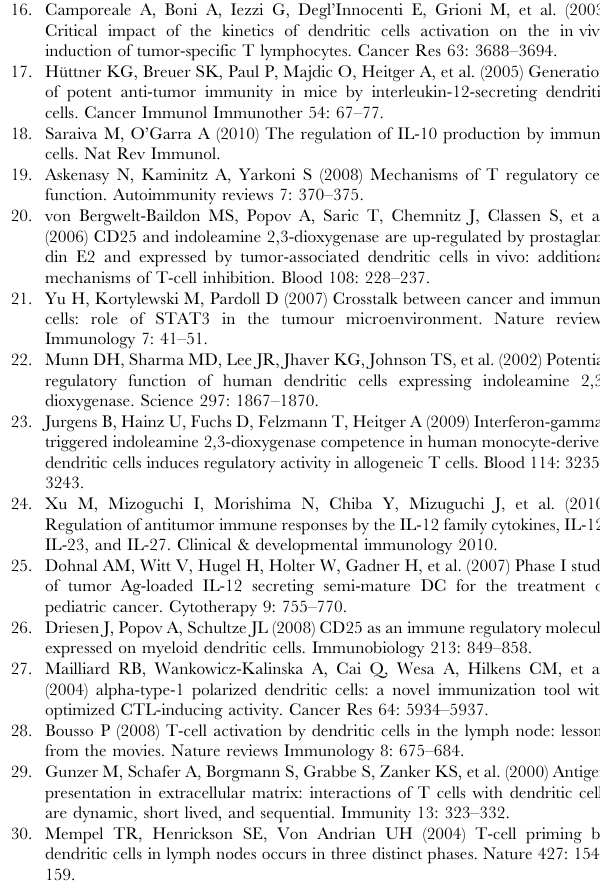
Figure S1 STAT3 expression in DC. (A) Comparison of STAT3 phosphorylation levels in human DCs after exposure to LPS (black line), LPS/IFN- c (dotted line), IFN- c alone (black hairline), or un-stimulated DCs (filled gray histogram). One representative experiment out of 2 is shown. (B) STAT3 phosphorylation was measured in un-stimulated human DCs (filled gray histogram) and at the indicated time points after DC activation with LPS (black line). One experiment out of 2 is shown. DCs from Donor F were used in experiment (A) to (B). (TIFF) Figure S2 DC/T-cell co-culture sorting strategy. Human DCs and T-cells (TCs) were co-cultured for 6 hours before flow sorting based on their mophological differences in size and granulosity and the CFSE positivity of T-cells. Unsorted DC/T- cell co-cultures (A), T-cell (B) and DC (C) fraction after flow sorting are shown as one representative out of 13 independent experiments. Absolute cell count of viable, DAPI negative cells was assessed using BD Trucount beads (indicated as ‘‘beads’’). Figure S3 Blocking CD40/CD40L signaling. Immature DC were exposed to LPS/IFN- c or co-cultivated with a cell line engineered to express CD40L molecules (SJ-NB-7/CD40L). For blocking CD40/CD40L-mediated maturation signals in DCs the co-cultures we supplemented with reactive NA/LE anti-human CD40, CD40L, or both. The mean fluorescence intensity (MFI) of